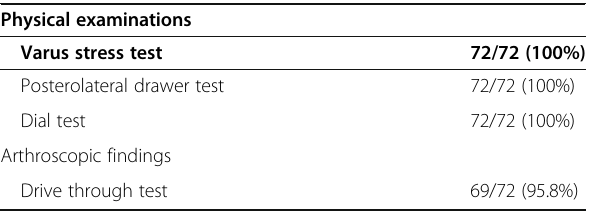
Table 4 The positive rates of physical examinations and arthroscopic